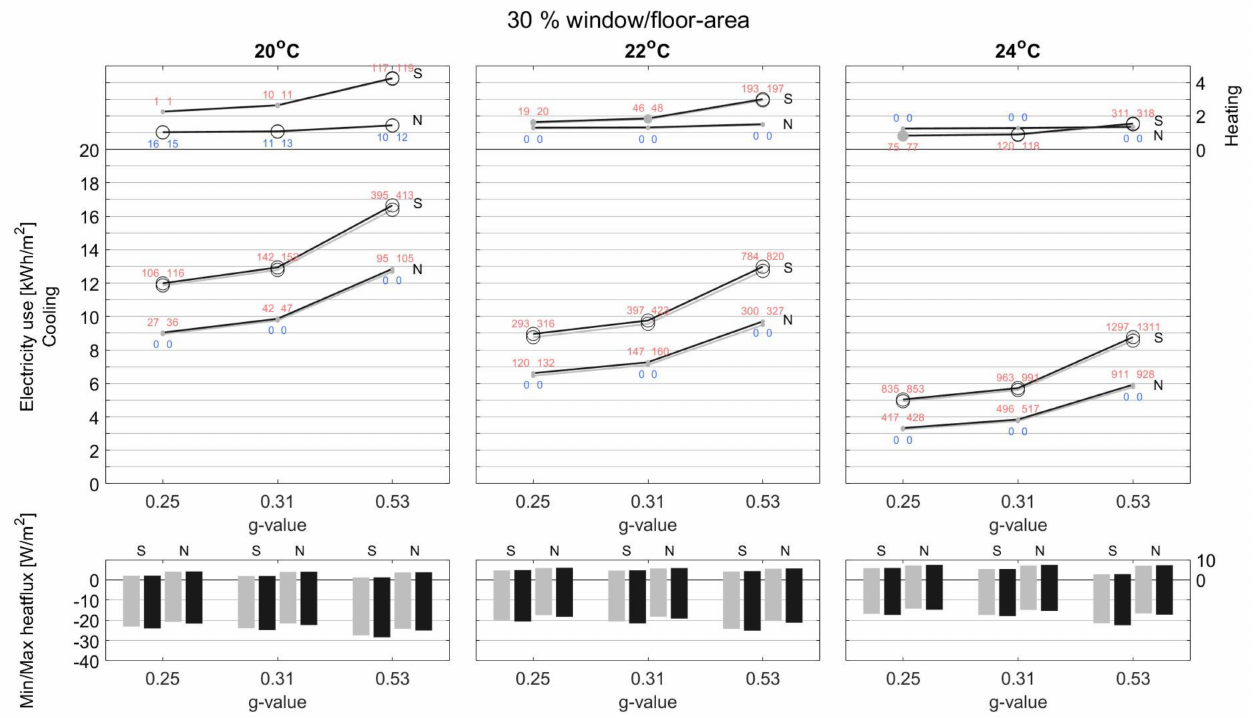
Figure A5. Munich meeting.